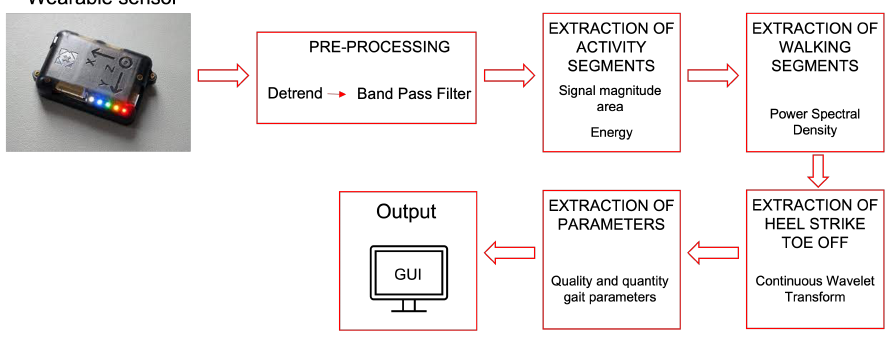
Figure 2. Block diagram of the proposed